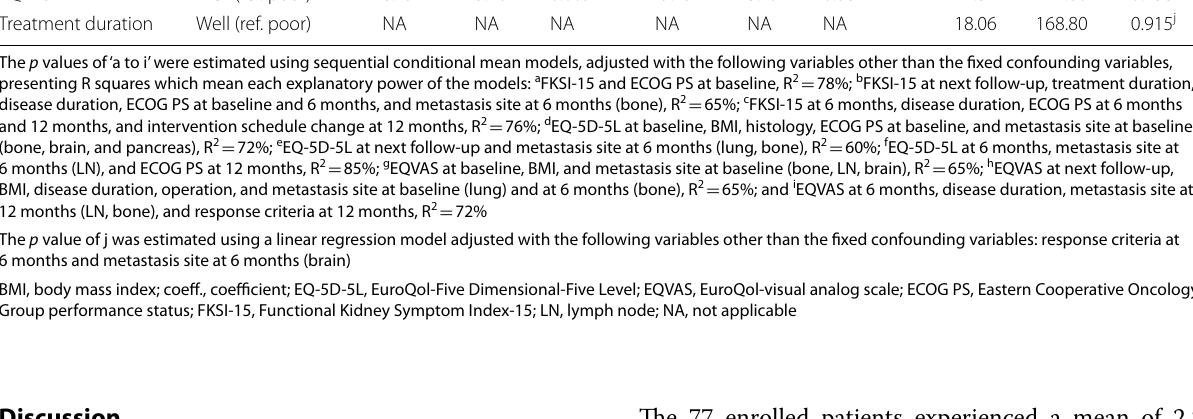
Table 4 Multivariate analysis for comparison of outcomes according to patients’ self‑management of AEs